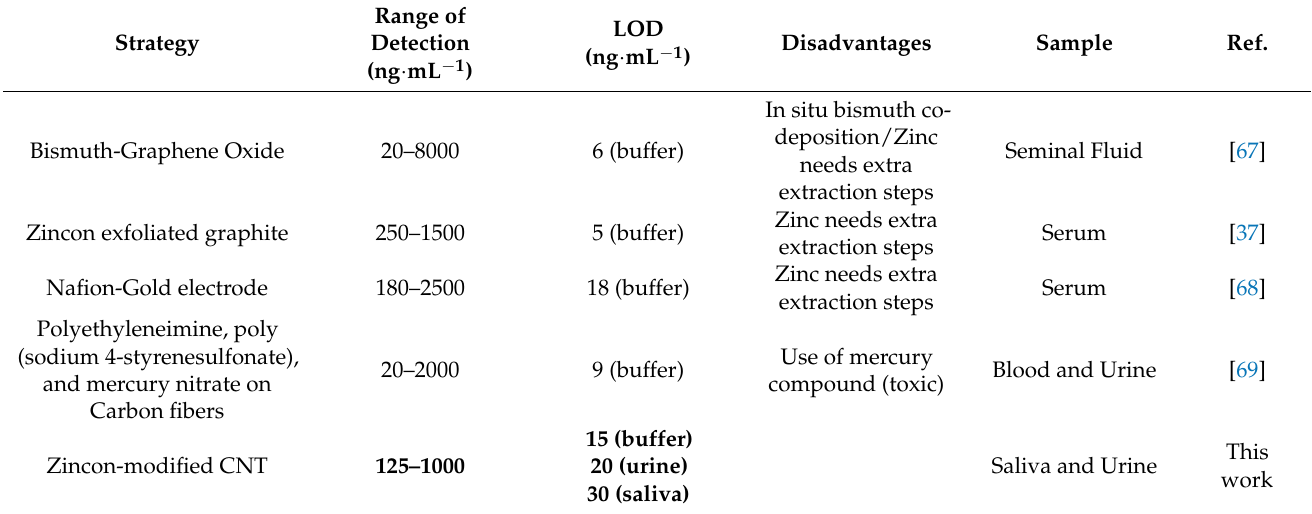
Table 3. Comparison of reported electrochemical quantification of zinc in different body